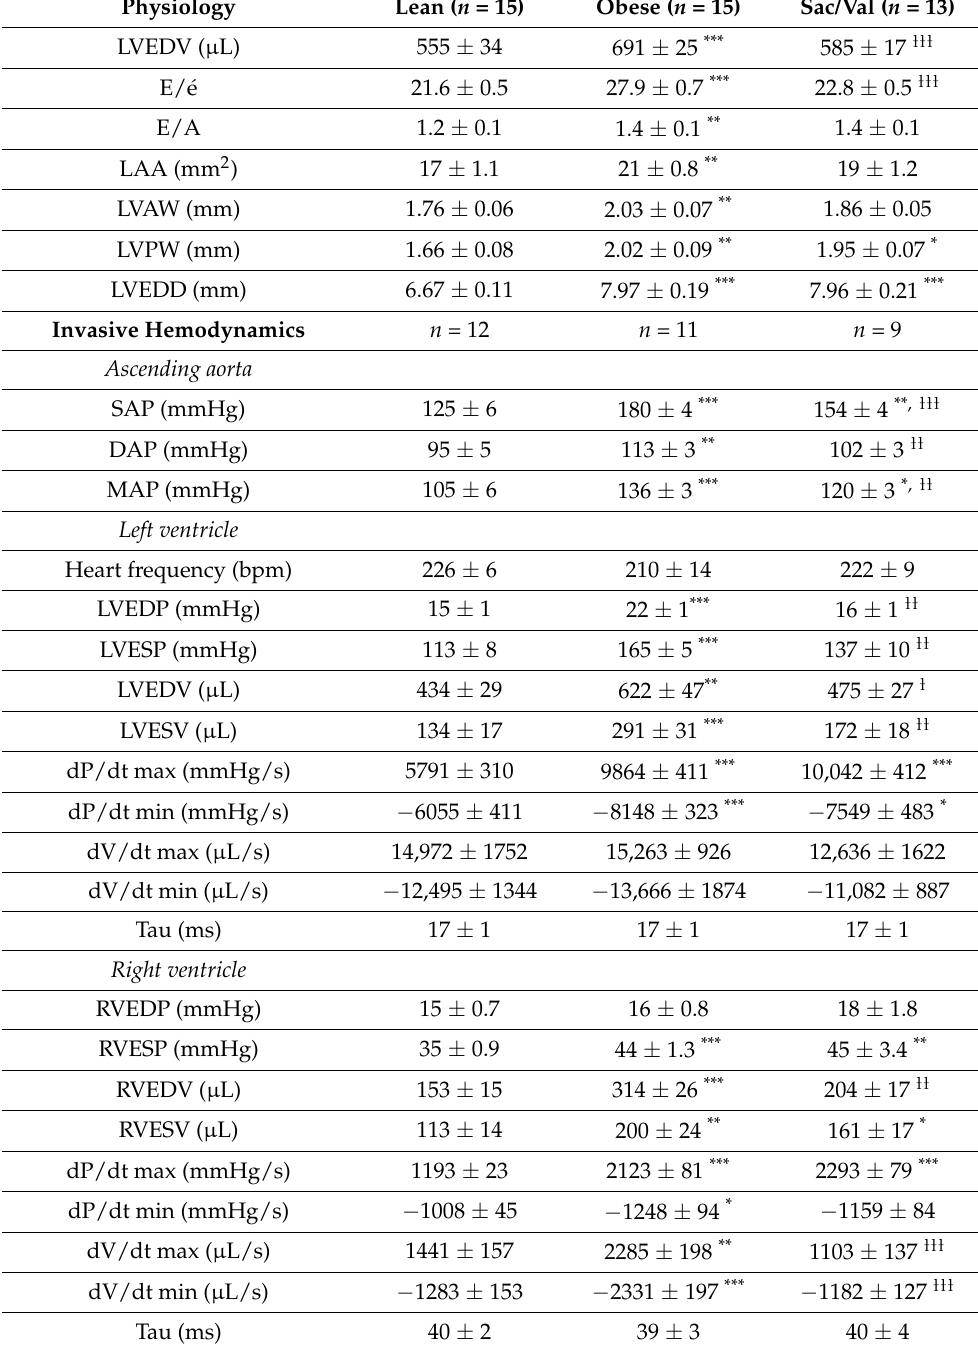
Values are presented as Mean ± SEM. * p < 0.05, ** p < 0.01, *** p < 0.001 vs. Lean, respectively. ł p < 0.05, łł p < 0.01, łłł p < 0.001 vs. obese, respectively. LVEF: left ventricular ejection fraction; LVFS: left ventricular fractional shortening; LVEDP left ventricular end-diastolic pressure; LVESP: left ventricular end-systolic pressure; LVEDV: left ventricular end-diastolic volume; LVESV: left ventricular end-systolic volume; LAA: left atrial area; LVAW: left ventricular anterior wall; LVPW: left ventricular posterior wall; LVEDD: left ventricular end-diastolic diameter; SAP: systolic arterial blood pressure; DAP: diastolic arterial blood pressure; MAP: mean arterial blood pressure; RVEDP: right ventricular end-diastolic pressure; RVESP: right ventricular end-systolic pressure; RVEDV: right ventricular end-diastolic volume; RVESV: right ventricular end-systolic